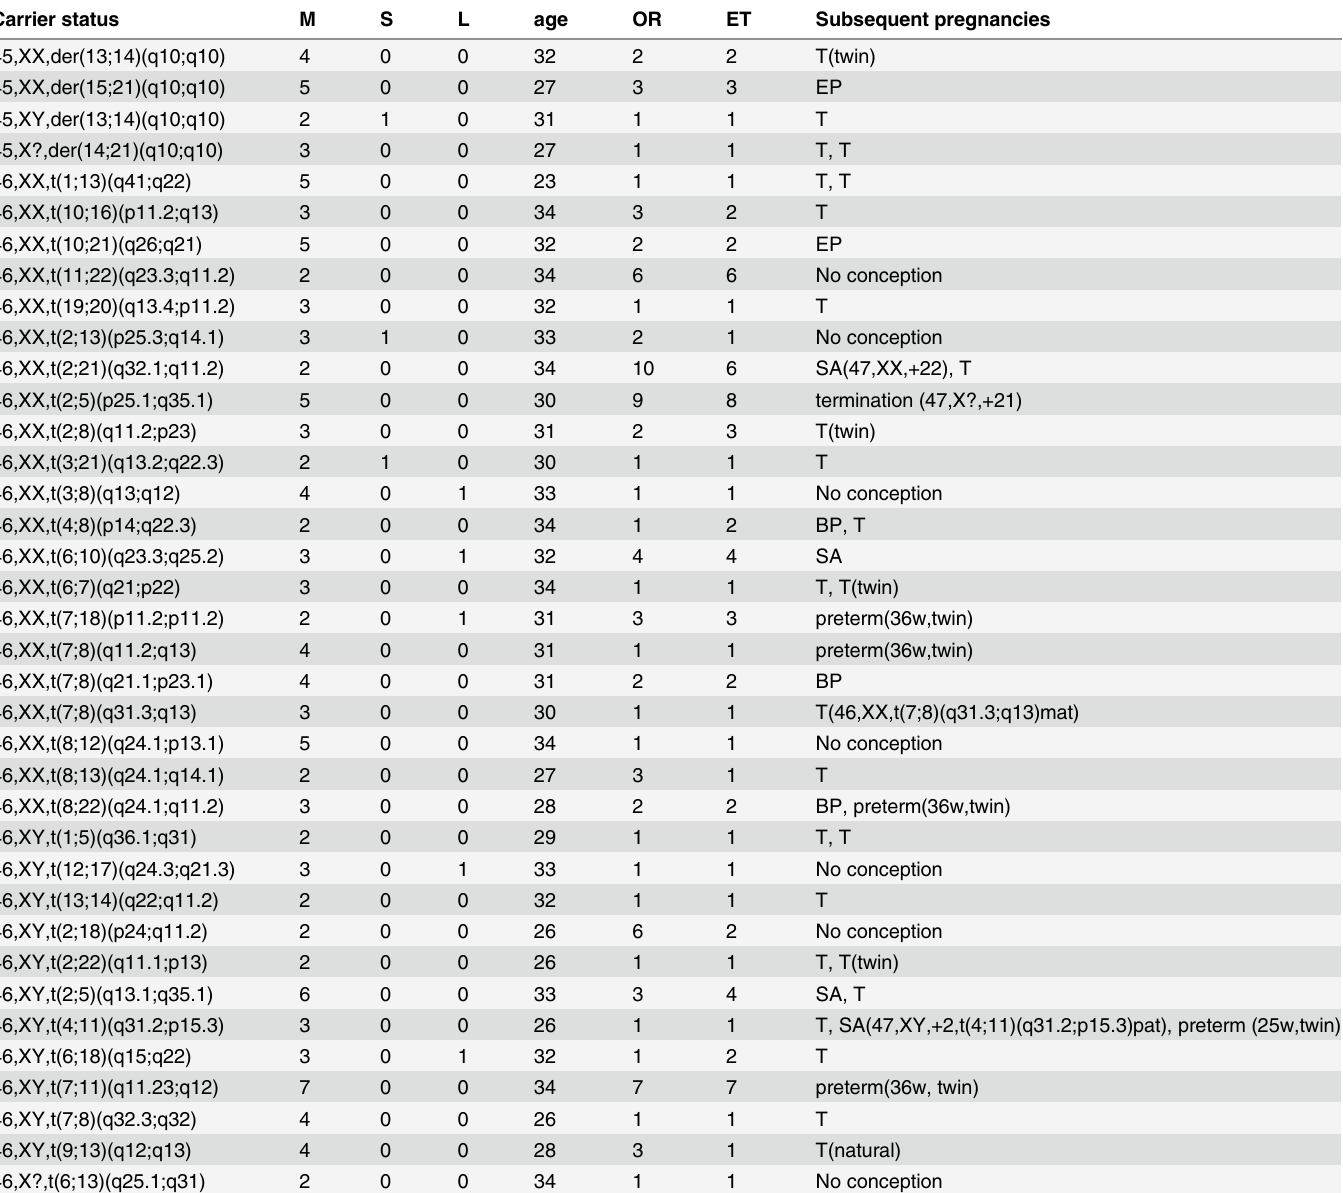
Table 2. Carrier status of the 37 patients who underwent